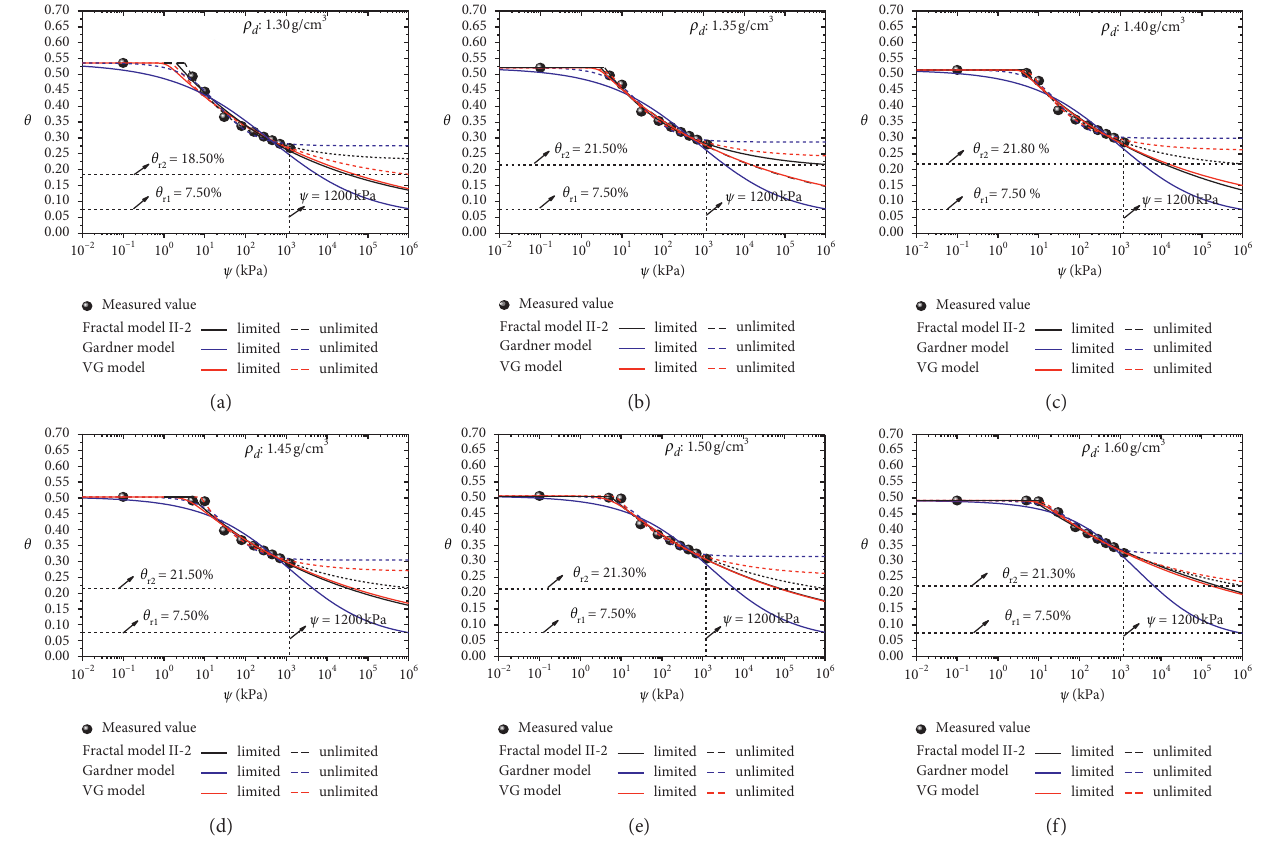
Figure 5: Fitting comparison diagram of limited and unlimited residual water content Table 6: The fitting value and the measured value of residual water content θ